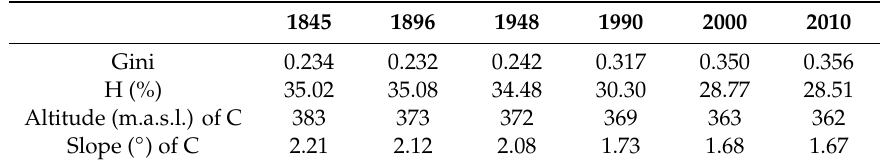
Table 3. Changing distribution of arable land: Gini, H, average altitude, and slope for the concentrated half of BTUs